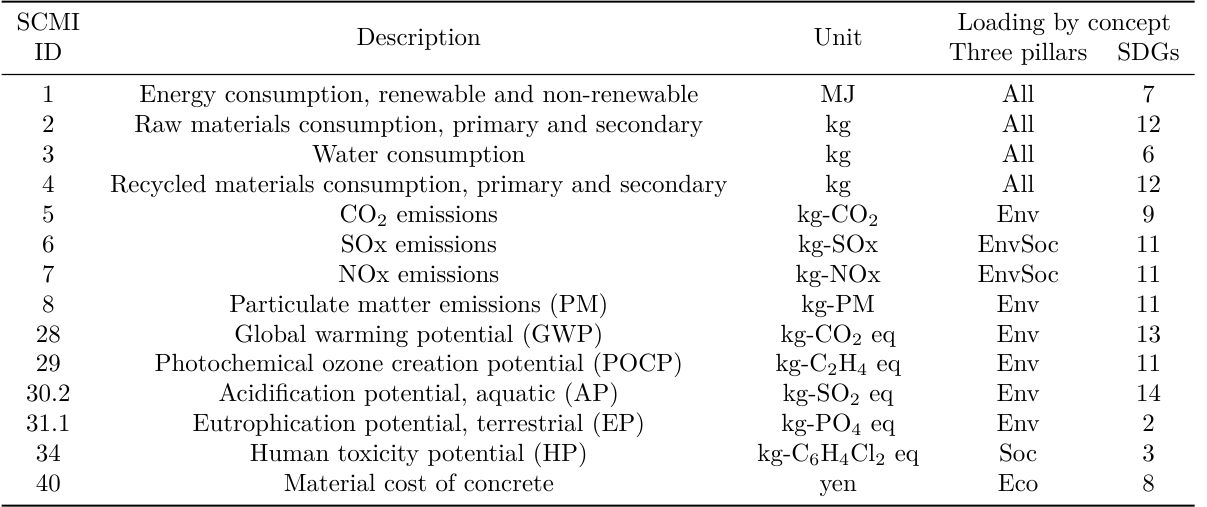
Table 2. Summary of the adopted sustainable concrete material indicators.